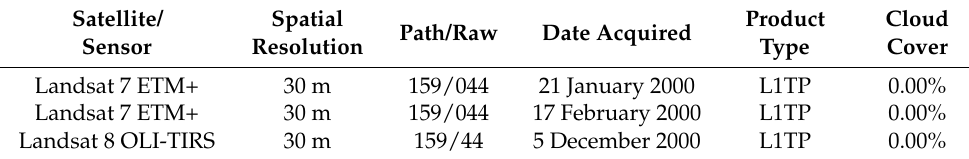
Table 1. Details of Landsat satellite